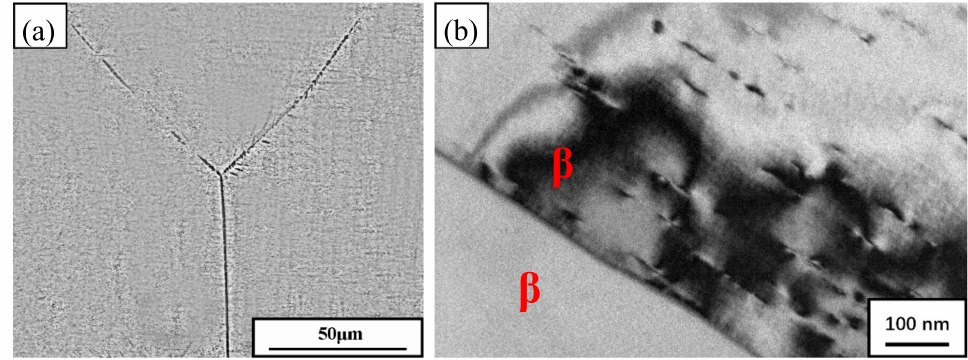
Figure 5. Microstructures of Ti-55531 after compressing to the peak stress at 825 ◦ C/1 s − 1 (discontinuous yielding).